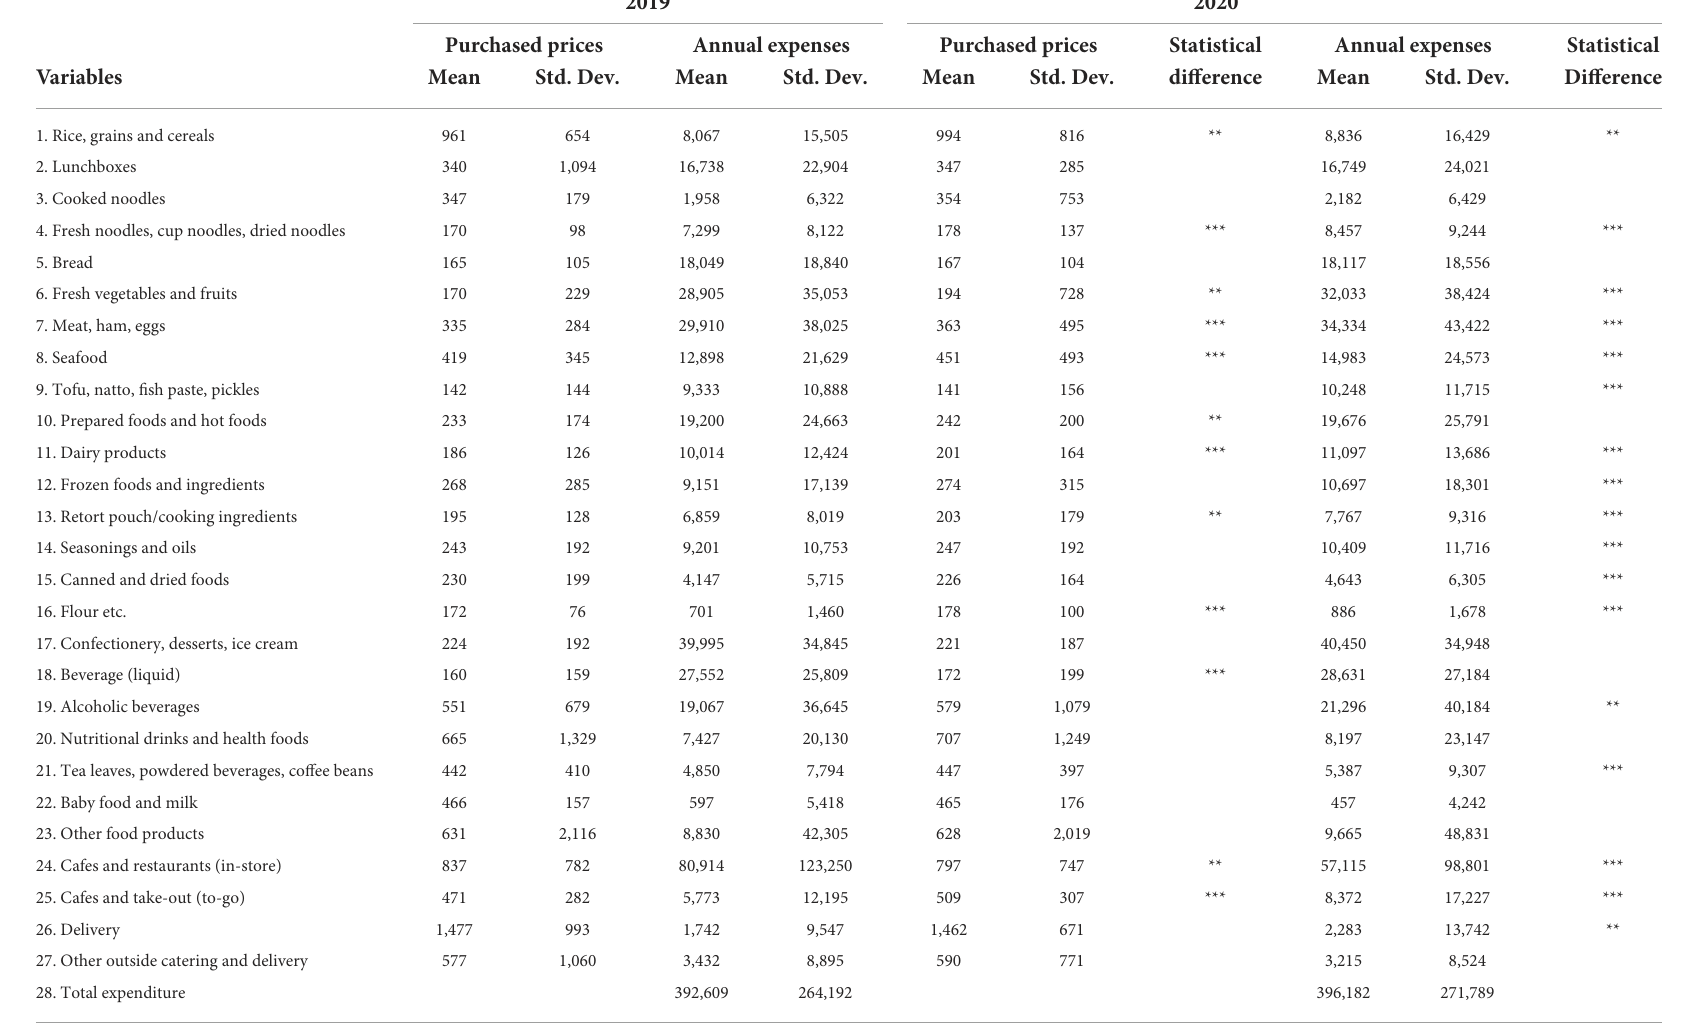
TABLE 2 Descriptive statistics of household expenses in 2019 and